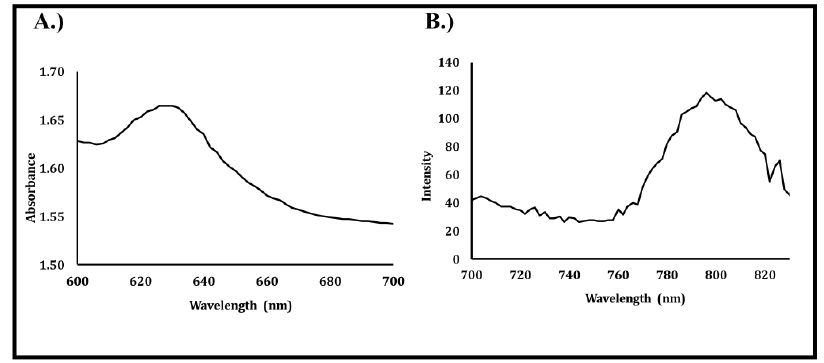
Figure 3. ( A ) Absorbance and ( B ) emission spectra of urate biosensor containing palladium (II) tetramethacrylated benzoporphyrin (BMAP) and uricase.